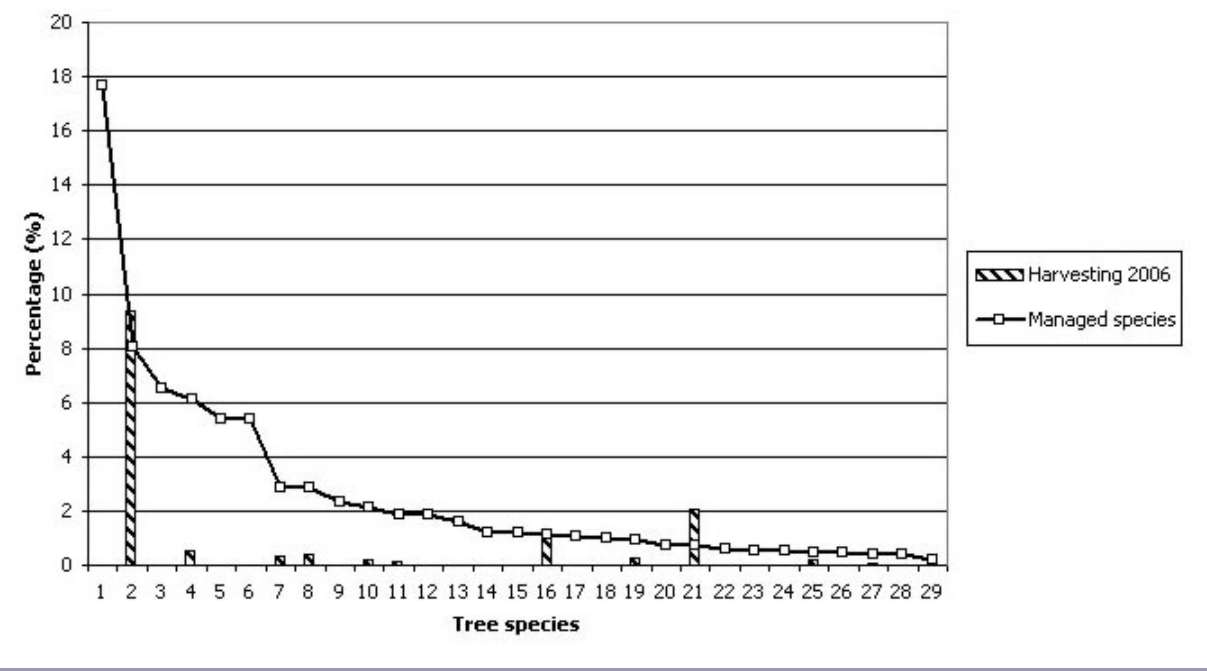
Fig. 1. Managed species of a sample concession (29 species, 76% of the total inventoried volume) and actual harvested species (as percentage of the concession’s total annual harvest in